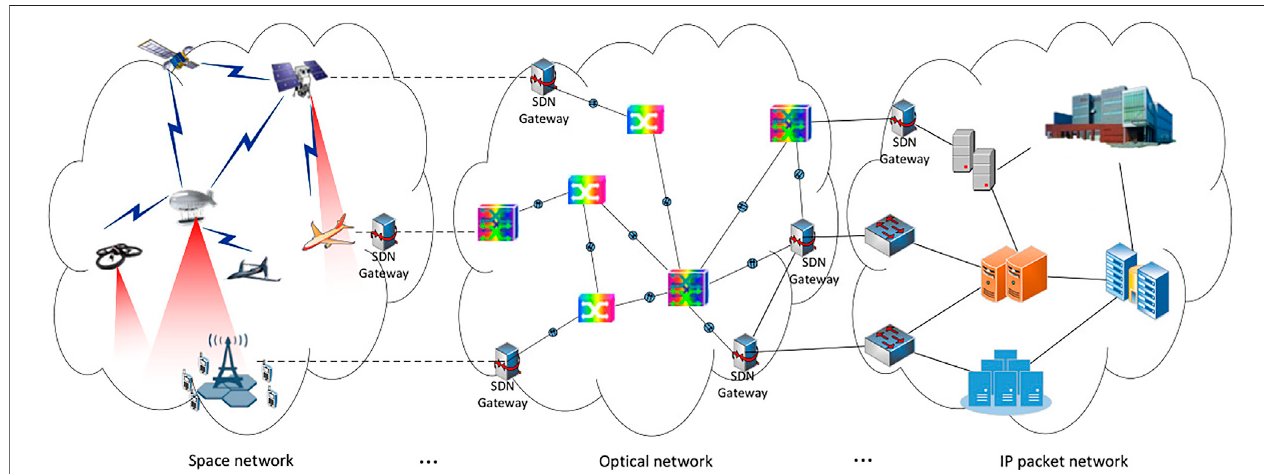
FIGURE 2 | The heterogeneous subnetworks of the integrated network including space networks, optical networks, IP packet networks, etc.